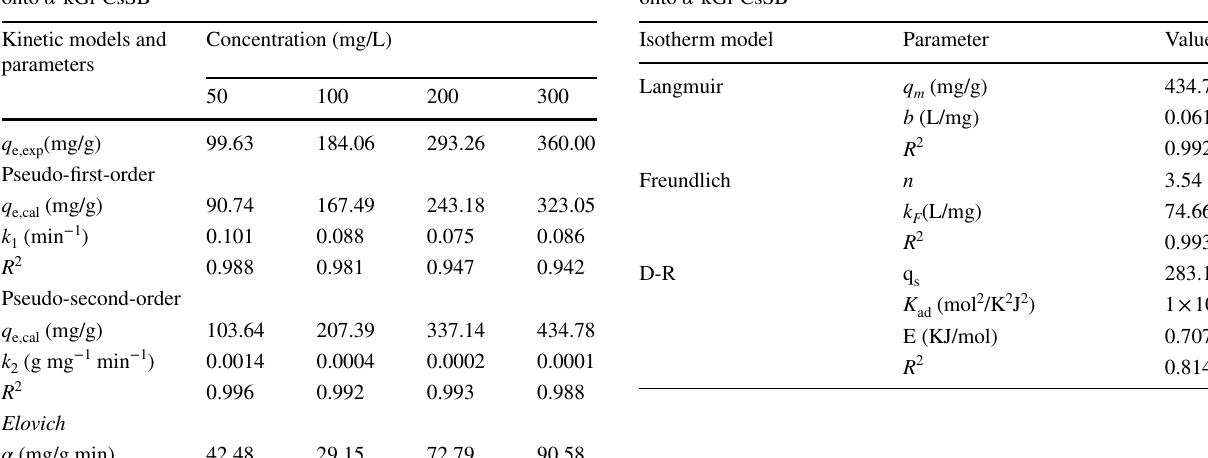
Table 2 Adsorption isotherm model parameters of the CR